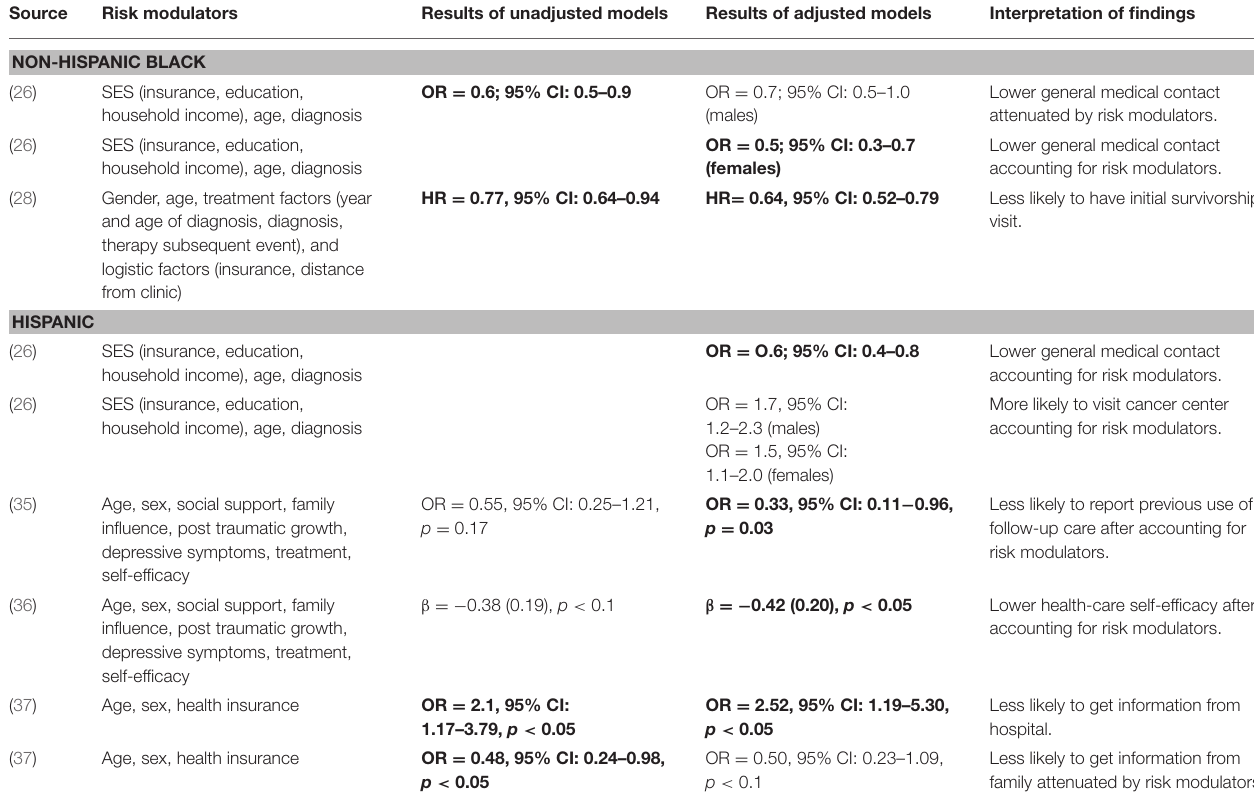
TABLE 2 | Factors influencing disparities in healthcare utilization for childhood cancer survivors by race/ethnicity.